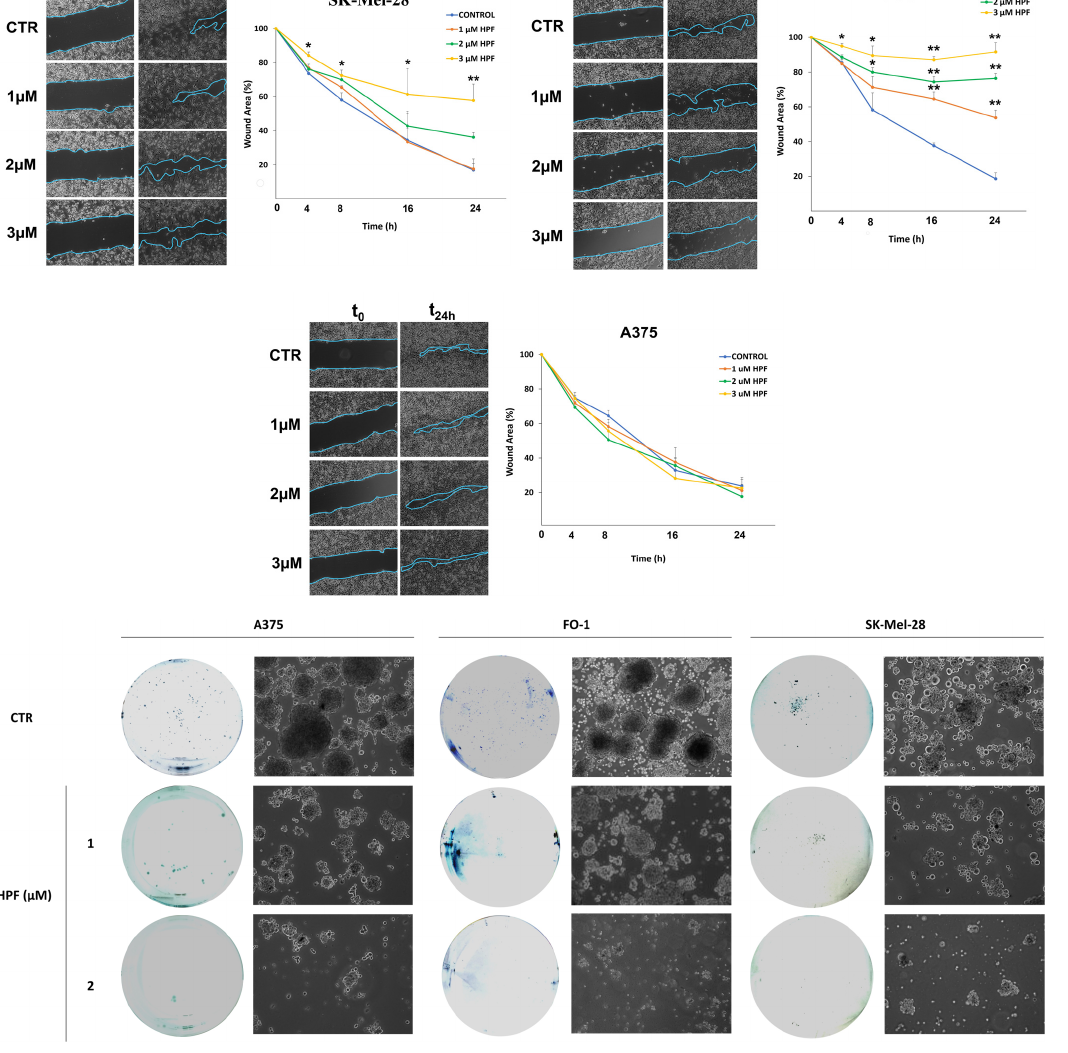
Figure 8. Hyperforin concentration dependently affects cell mobility and inhibits soft agar colony formation in melanoma cell lines. Top , wound healing assay attesting the inhibition of cell mobility by 2 and 3 µ M HPF in FO-1 and SK-Mel-28 melanoma cells but not in A375 cell line. Images were recorded with an inverted microscope (Axio Vert A1, Zeiss, Oberkochen, Germany). The images were analyzed quantitatively using ImageJ computing software (NIH Image, Bethesda, MD, USA). Bottom , images of colonies taken from representative experiments of colonies formed in soft agar. Representative images showing growth and density of colonies were taken by an inverted microscope (5 × magnification). * p < 0.05; ** p <